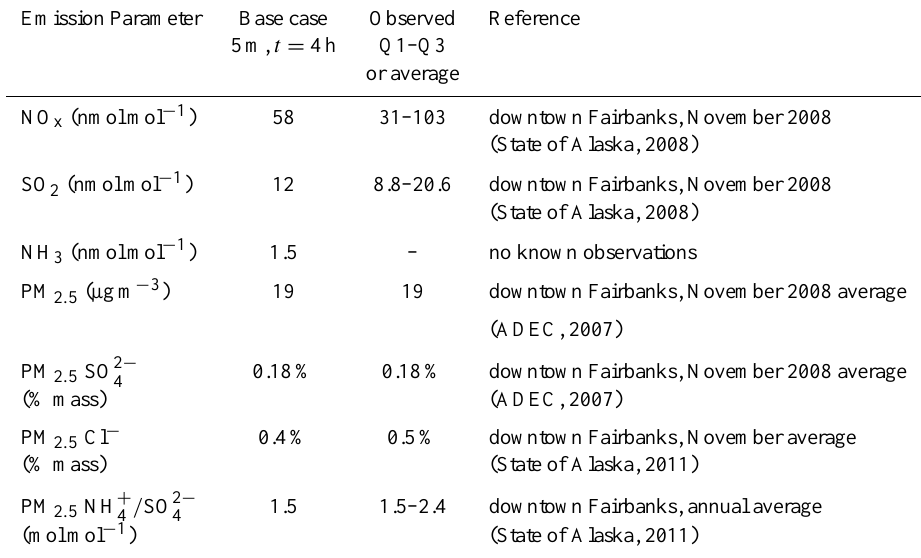
Table 1. Emissions of pollutants in the base model case (at end of emissions, t = 4h) and observations from downtown Fairbanks. Q1–Q3 refers to first to third quartile